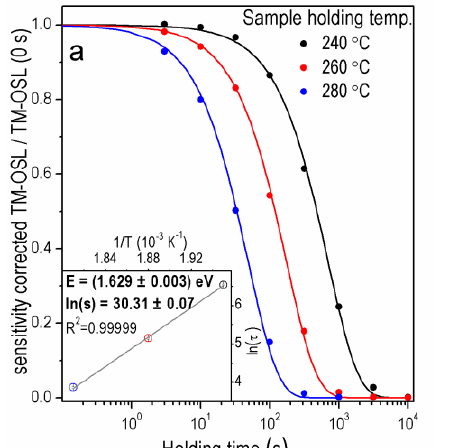
Figure 4. The OTDCs for one aliquot of the FB sample using TM-OSL 620 nm procedure after irradiation with dose 1000 Gy and preheating: ( a ) 280 °C, FOM 250 = 1.89%, FOM 260 = 3.17%, FOM 270 = 2.03%, FOM 280 = 2.33%, ( b ) 150 °C, FOM 240 = 2.75%, FOM 260 = 4.13%, FOM 280 = 3.91%.